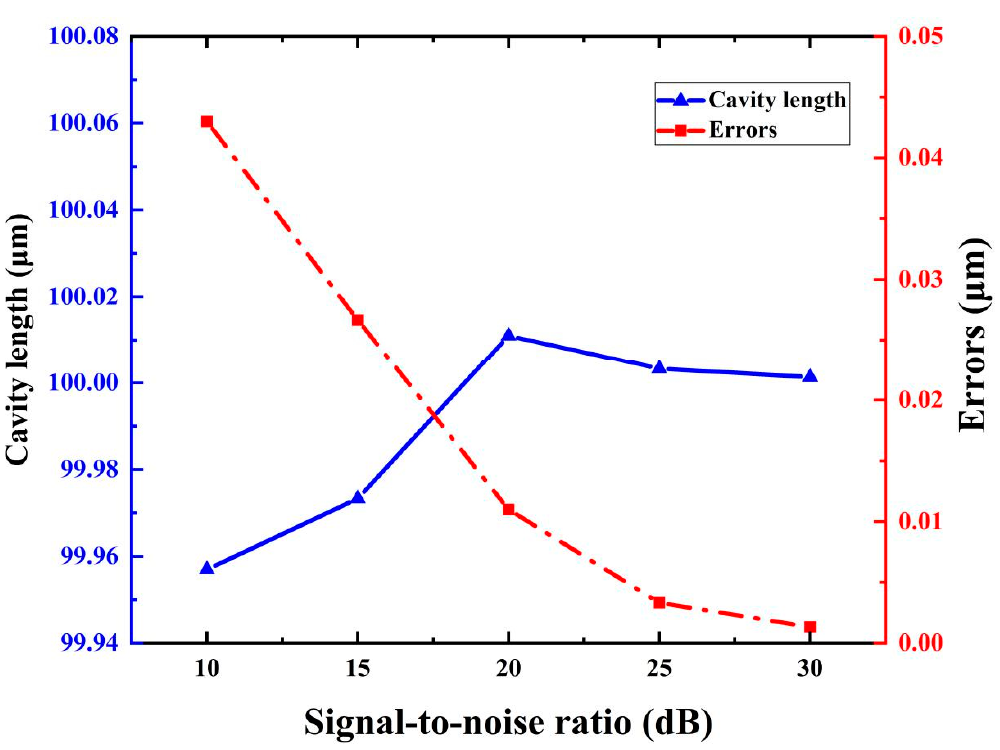
Figure 6. Simulated interrogation results and errors of cavity length under di ff erent SNR conditions. In the zero-points selection, two periods were covered.